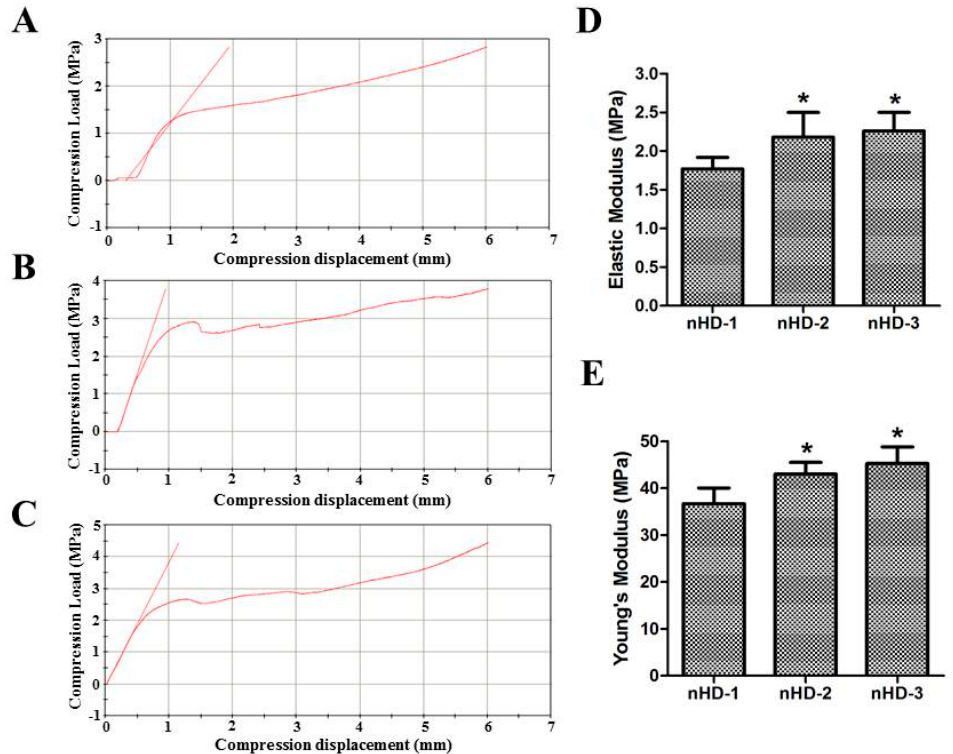
Figure 4. Mechanical properties of the three nHD scaffolds. ( A–C ) The compression loads of nHD-1 scaffolds ( A ), nHD-2 scaffolds ( B ) and nHD-3 scaffolds ( C ). ( D ) The elastic moduli of three nHD scaffolds. ( E ) The Young ′ s moduli of three nHD scaffolds; * p < 0.05 compared with nHD-1 scaffolds.